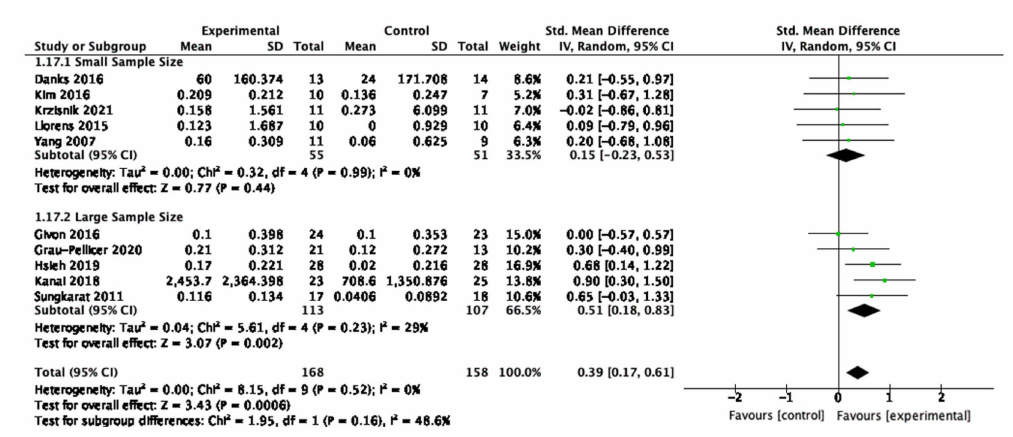
Figure 15. Sensitivity analysis for physical activity.